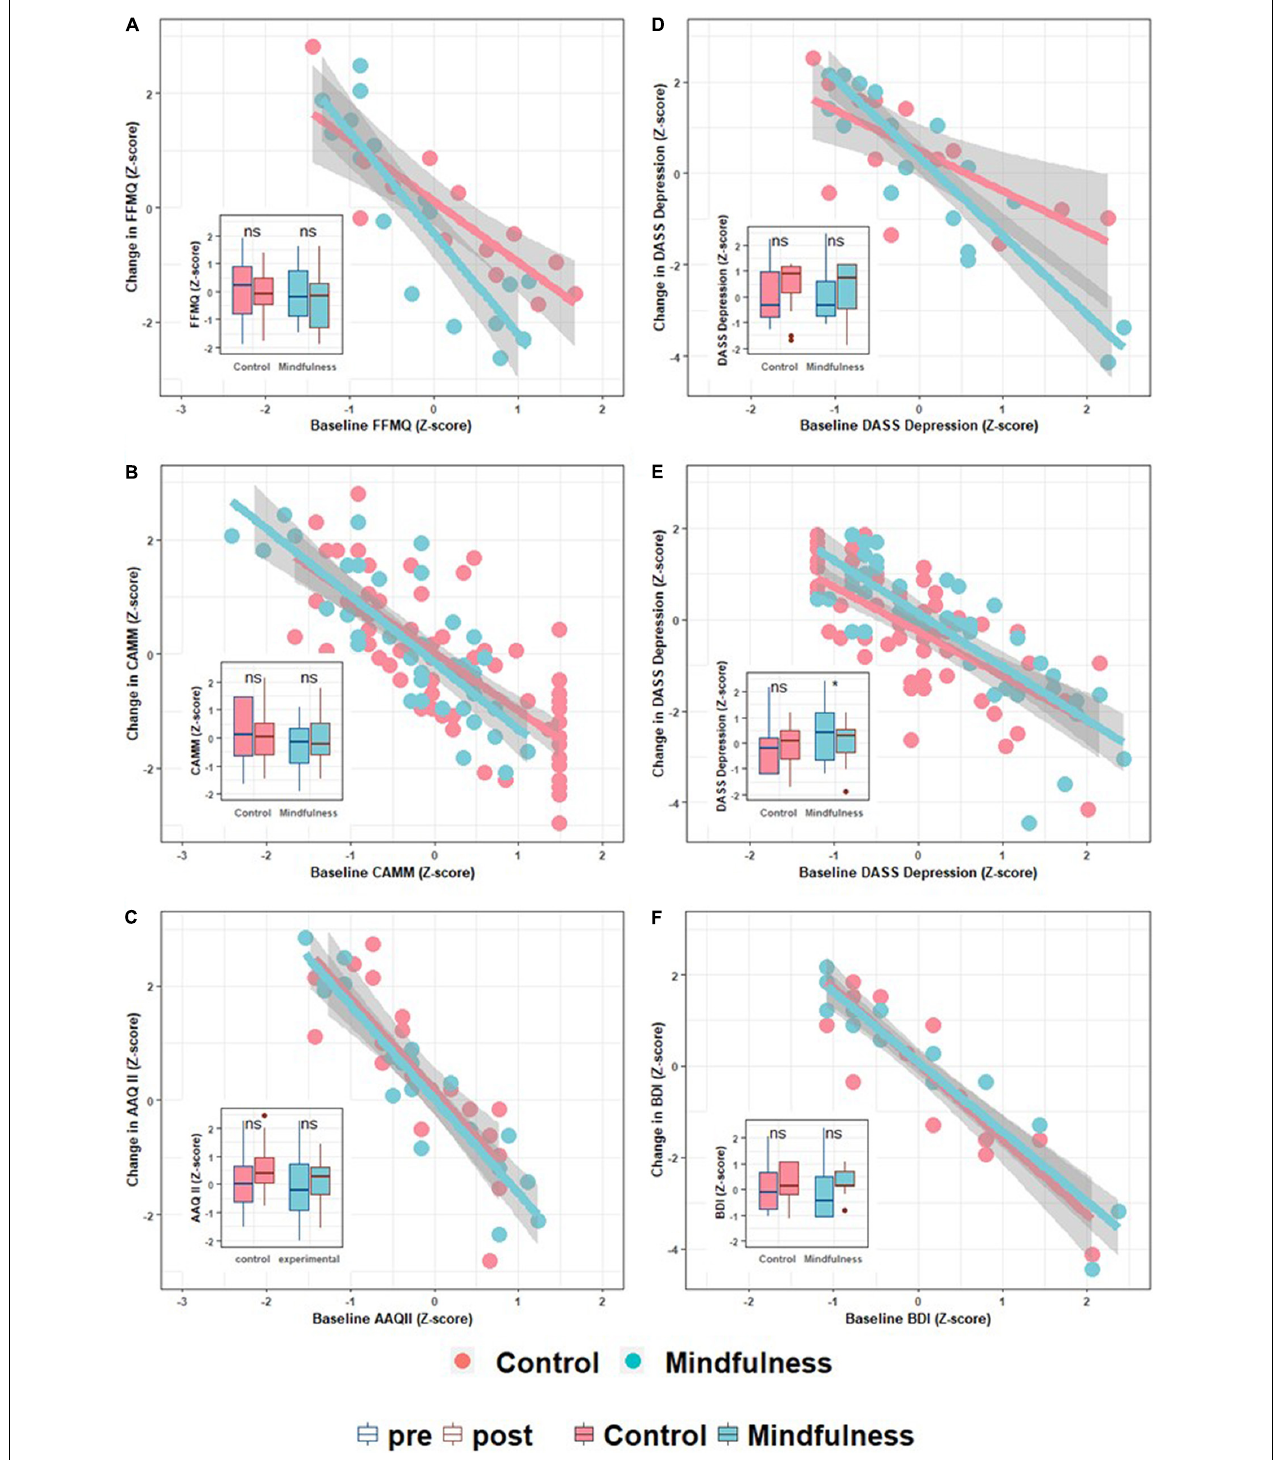
FIGURE 1 | Scatter and boxplots depicting intervention effects. In the scatter plots, the x -axis represents the baseline value for a specific variable, while the y -axis represents its change ( (cid:49) ) post intervention. The first column of the panel plots (A–C) are mindfulness-related variables, while the second (D–F) are psychopathology severity scores. Each row refers to a different sample. The first row is the Psychosis-MBCT sample (A,D) , the second row is the School-MiSP sample (B,E) , and the last row corresponds to the University-MBCT sample (C,F) . All plots are complemented by a boxplot inset depicting group pre- and post-intervention changes. This allows us to present both the participants’ trajectories (scatter plots) and the common group-based analytic approach (contrasting averages).